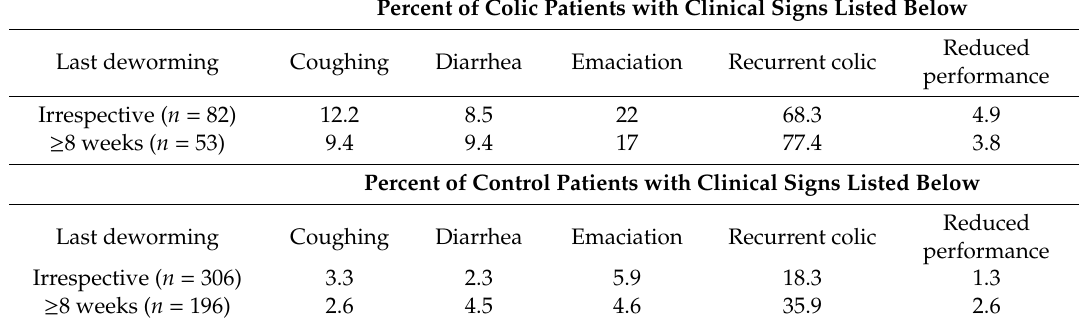
Table 3. Distribution of the clinical signs potentially associated with parasite infection reported in colic patients signs prior to admission (colic n = 82; control n = 306).